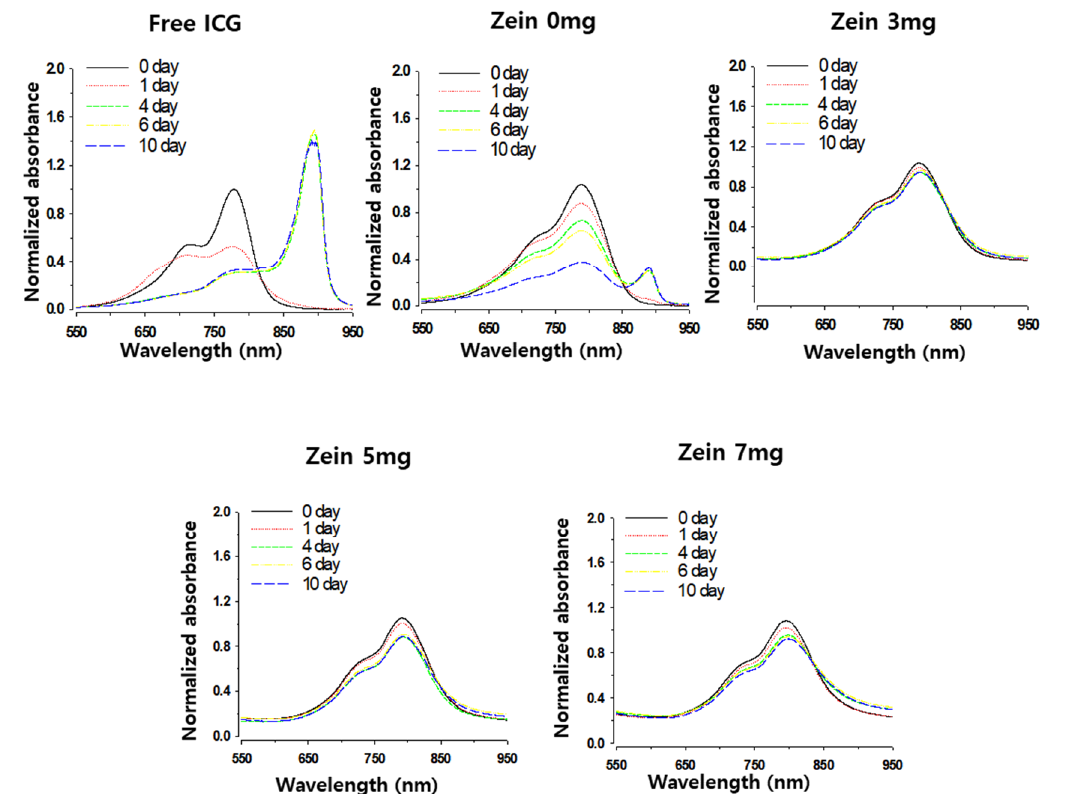
Figure 3. The effect of zein hybridization on the time-dependent formation of ICG J-aggregates. Changes in the absorbance spectrum of varying ICG formulations (0.85 mg/mL ICG concentration) were determined during incubation at room temperature. Free ICG solution was prepared in 5% D-glucose. The spectrum was obtained after sample dilution with 5% D-glucose and normalized by the 780 nm absorbance of each sample on the initial day.